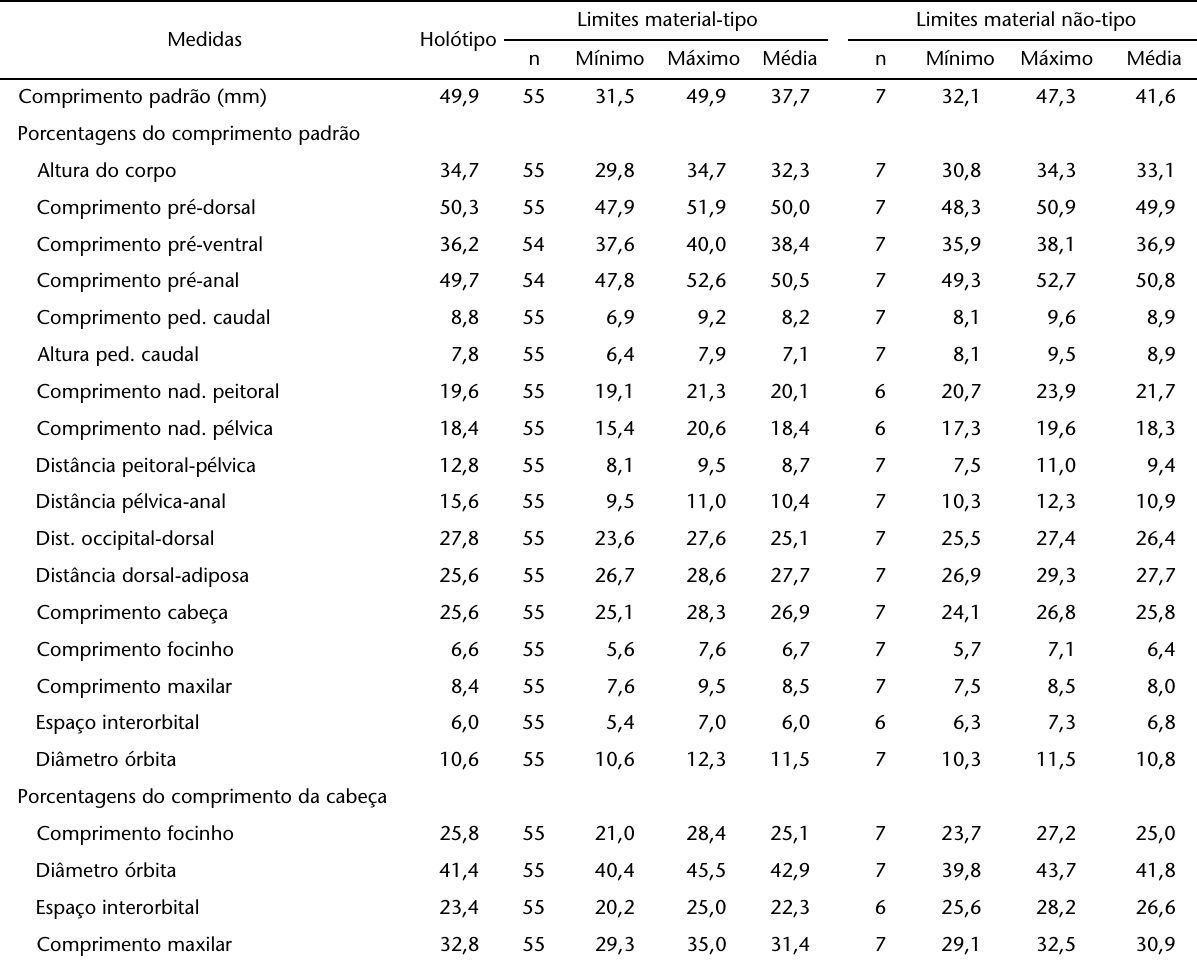
Tabela V. Medidas de P. prolatus sp. nov. , holótipo MBUCV-V 33242. (n) Número de exemplares, incluindo o